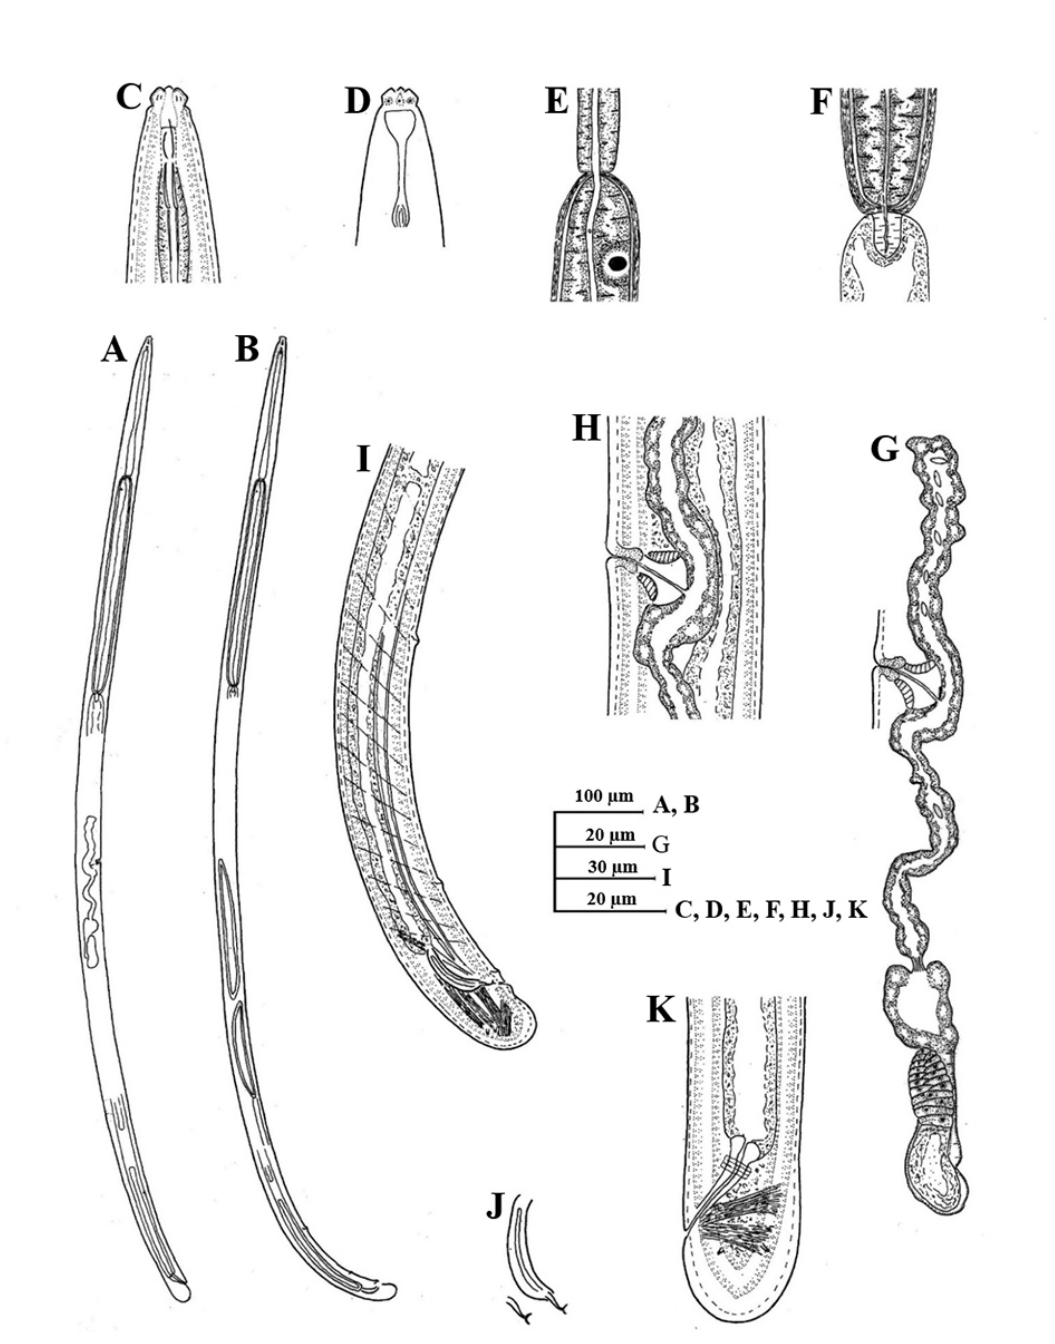
Fig . 7 . Axonchium microspiculum sp. nov. A , C – H , K . Holotype, ♀ (slide 1). B , I – J . Paratype 4, ♂ (slide 2). A . Entire female. B . Entire male. C . Anterior region. D . Anterior end showing amphid. E . Junc- tion between anterior slender and posterior expanded part of pharynx. F . Cardia. G . Female genital sys- tem. H . Vulva. I . Male posterior region. J . Spicule and lateral guiding piece. K . Female